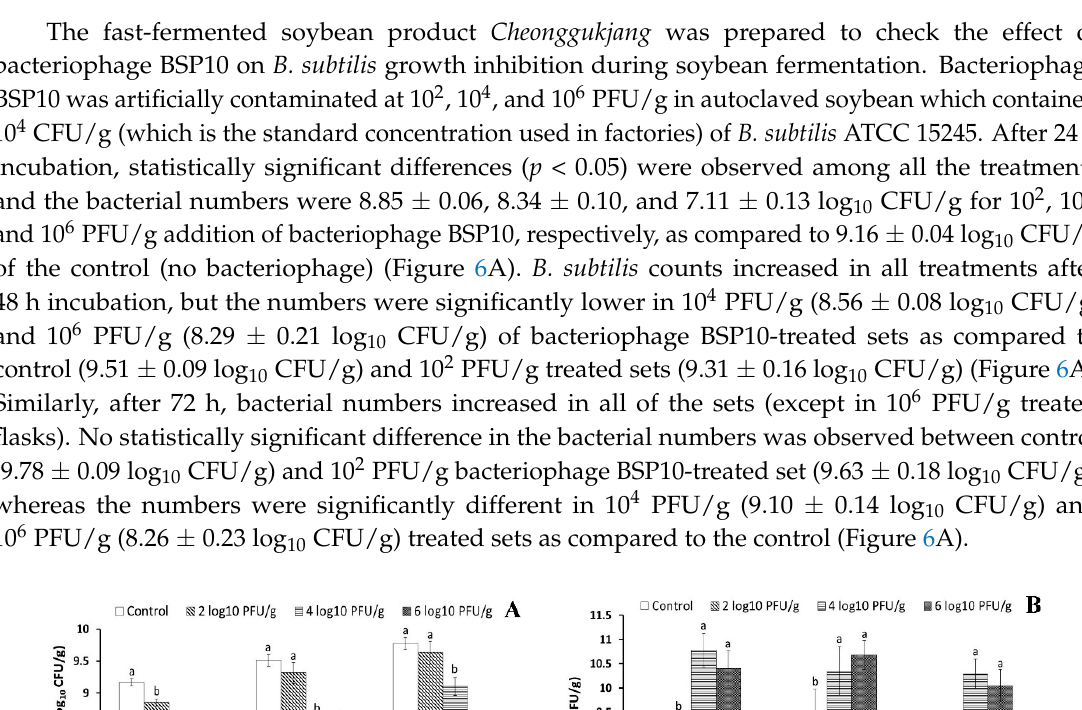
Figure 5. Growth inhibition of B. subtilis ATCC 15245 in liquid culture by bacteriophage BSP10 ( A ) and propagation of bacteriophage BSP10 during liquid culture inhibition ( B ). B. subtilis ATCC 15245 was grown in TSB liquid media and bacteriophage BSP10 was added at MOIs of 1 and 0.1 after 2 h of bacterial inoculation. The data were presented as mean ± SD.